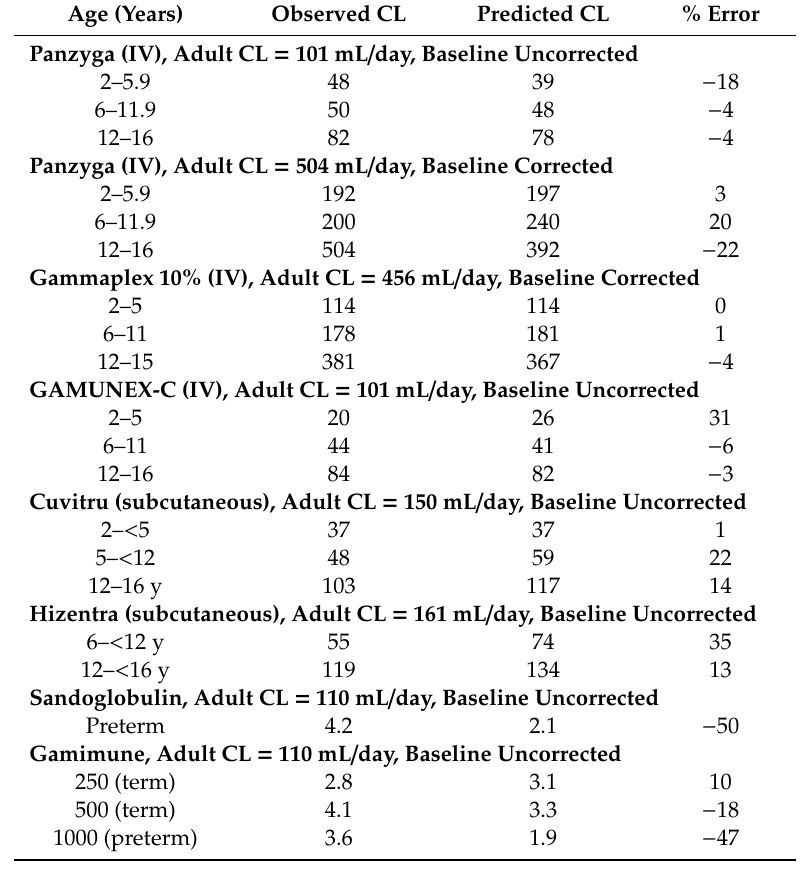
Table 2. Predicted and observed clearance of polyclonal antibodies in children of di ff erent ages.